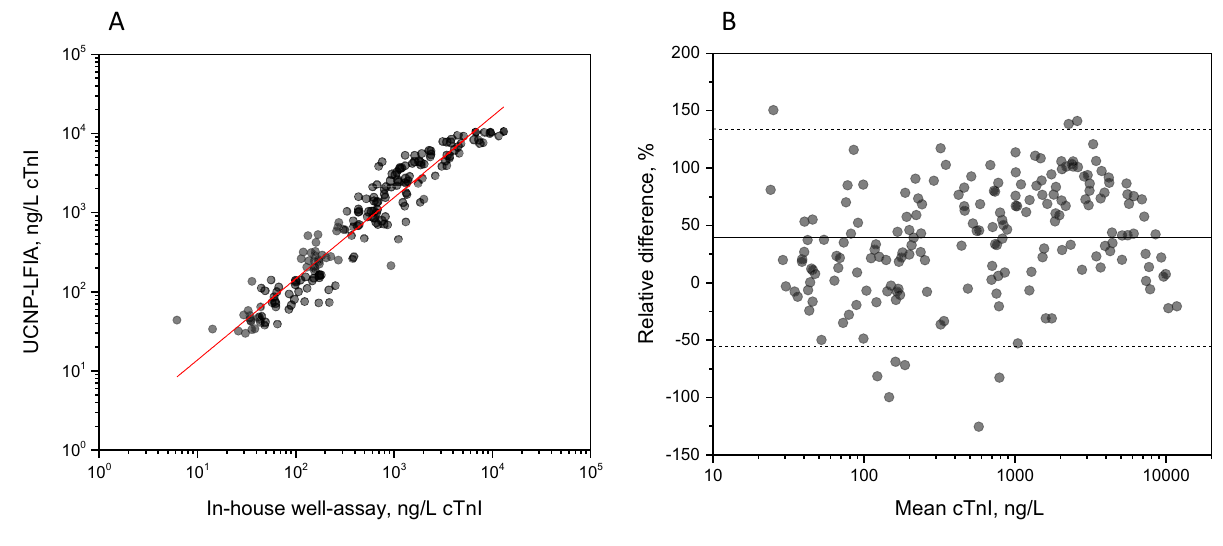
Figure 3. Method comparison between the UCNP-LFIA and the in-house well-based reference assay (n = 188). ( A ) Correlation of the assays and ( B ) Bland–Altman analysis of agreement. The relative difference is calculated as UCNP-LFIA concentration subtracted by in-house well-based assay concentration divided by mean concentration. The mean difference (39.4%) is presented with a solid line and the 95% limits of agreement (from − 55.1 to 134%) are shown with dashed lines.